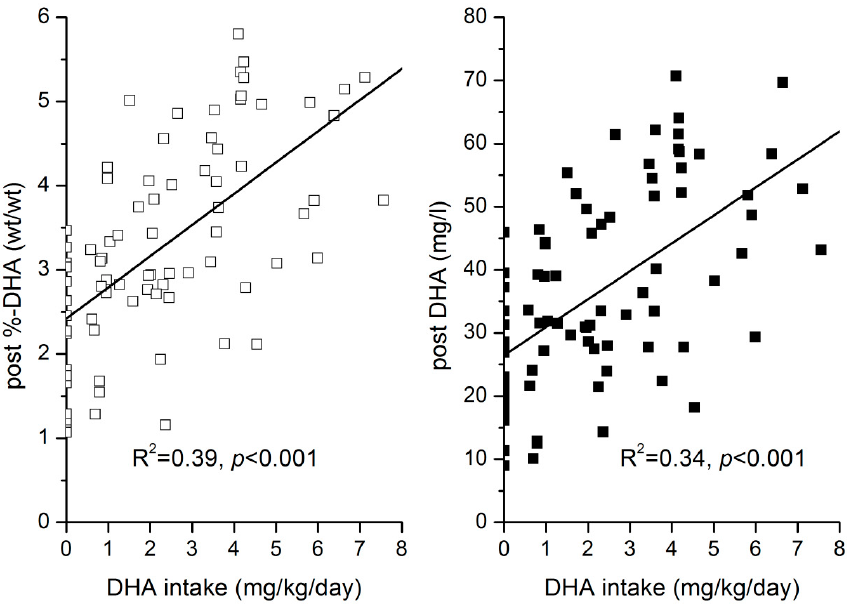
Figure 4. Linear relationship between DHA intake (mg/kg&day) and post intervention phosphoglycerid bound DHA concentration ( (cid:3) ) and percentage contribution of DHA to total analysed glycerophospholipid fatty acids ( (cid:4) ).